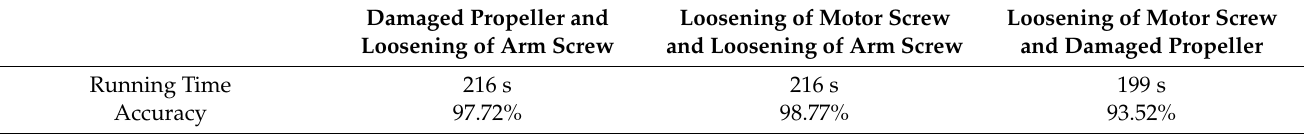
Table 7. The best double fault kNN classification model based on time-frequency domain data analysis.